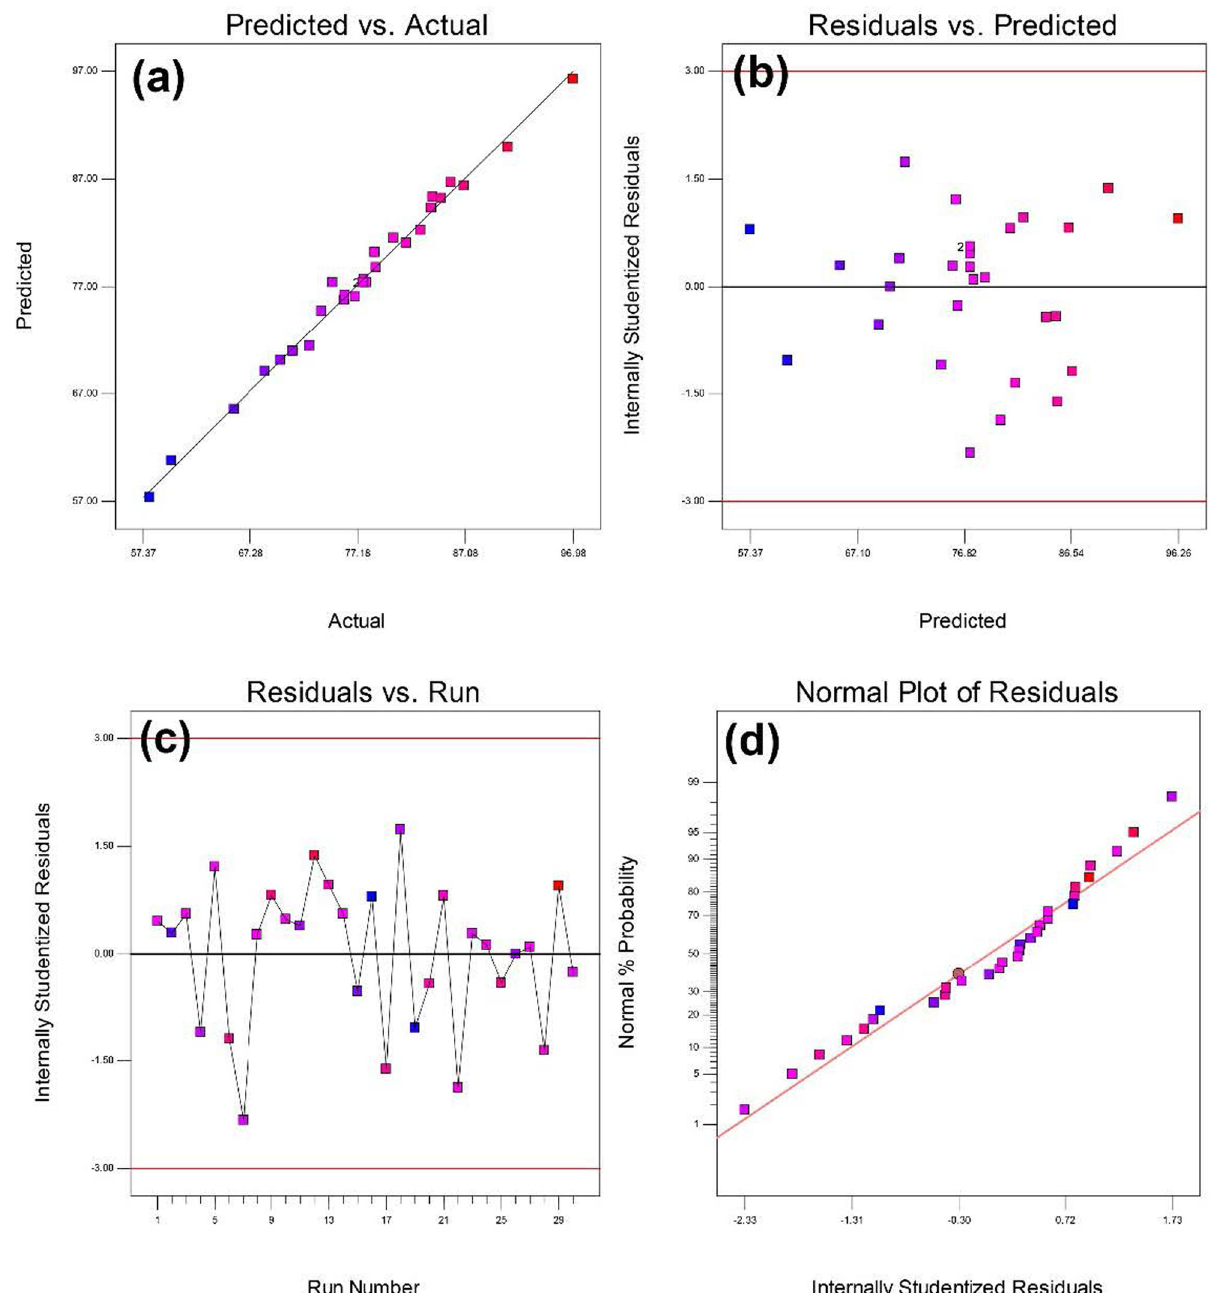
Fig. 4 Statistical plots for Methylene Blue removal by CdSe. a Plots of actual values versus predicted ones. b The Internally Studentized Residuals versus predicted ones. c The Internally Studentized Residuals versus run number. d Normal plot of